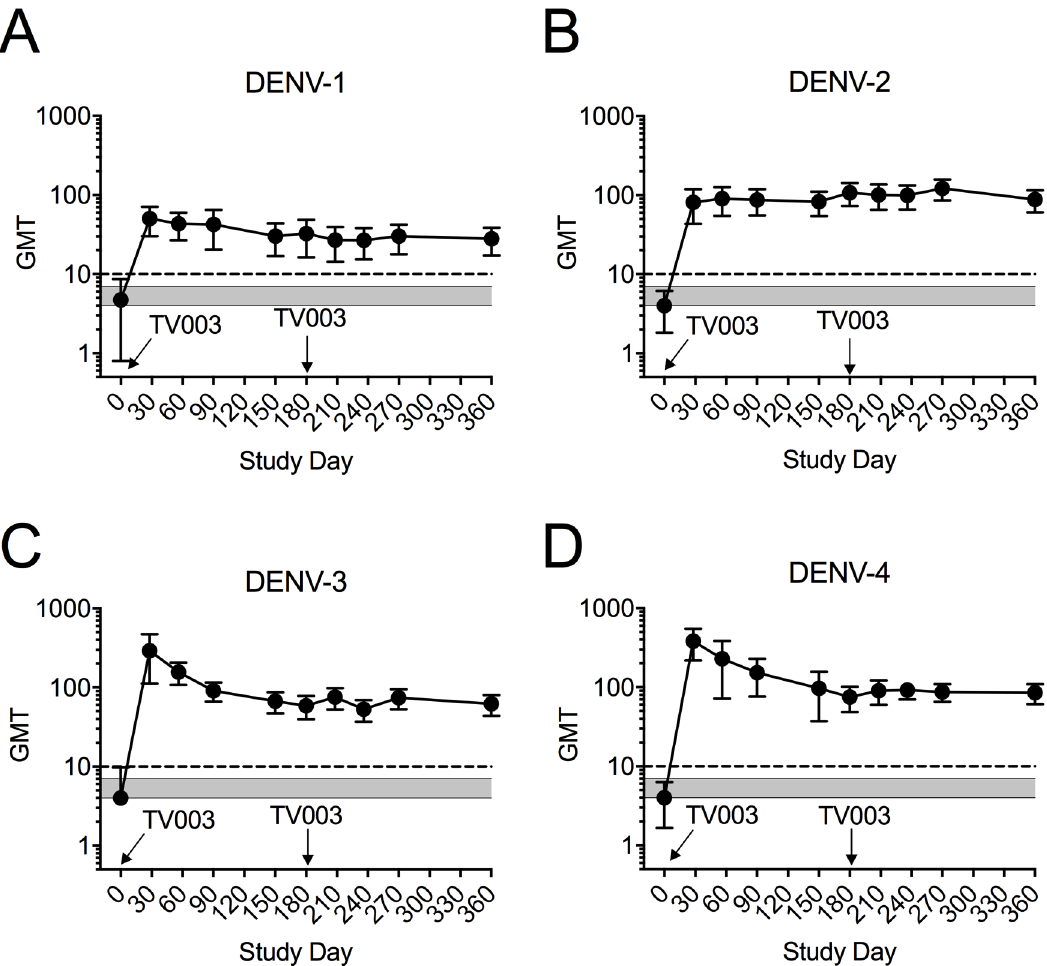
Fig 2. Mean plaquereduction (50%) neutralizing titers (PRNT 50 ) for DENV-1 ( A ), DENV-2 ( B ), DENV-3 ( C ), and DENV-4 ( D ) followingone or two doses of TV003 in flavivirus-experienced subjects (n = 41 for Dose 1, and n = 33 for Dose 2). All data represent mean titers (GMT) ± 95% confidenceinterval. Dotted line indicatesseropositivity (PRNT 50 (cid:21) 1:10) and gray area represents the range of Ab levels to each serotype observed in subjectswho receivedplacebo(n = 17 for dose 1 and n = 15 for Dose